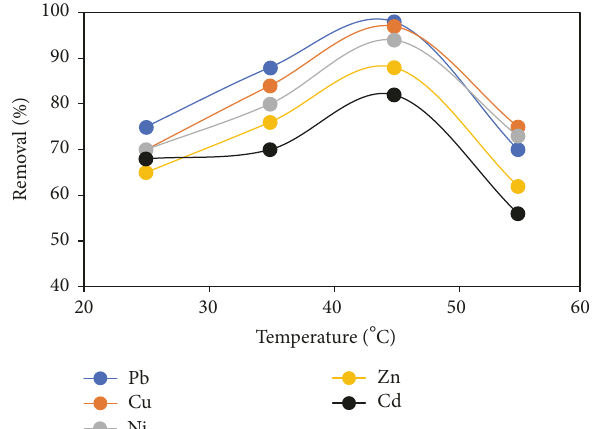
Figure 11: Effect of FGCX dose on percentage removal of heavy metal ions (conditions: pH: Pb = 5, Cu = 5, Ni = 7, Zn = 6, and Cd = 6; contact time: 60min; initial concentration: 0.5 mmol/L; agitation speed: 120 rpm; temperature: 45 ∘